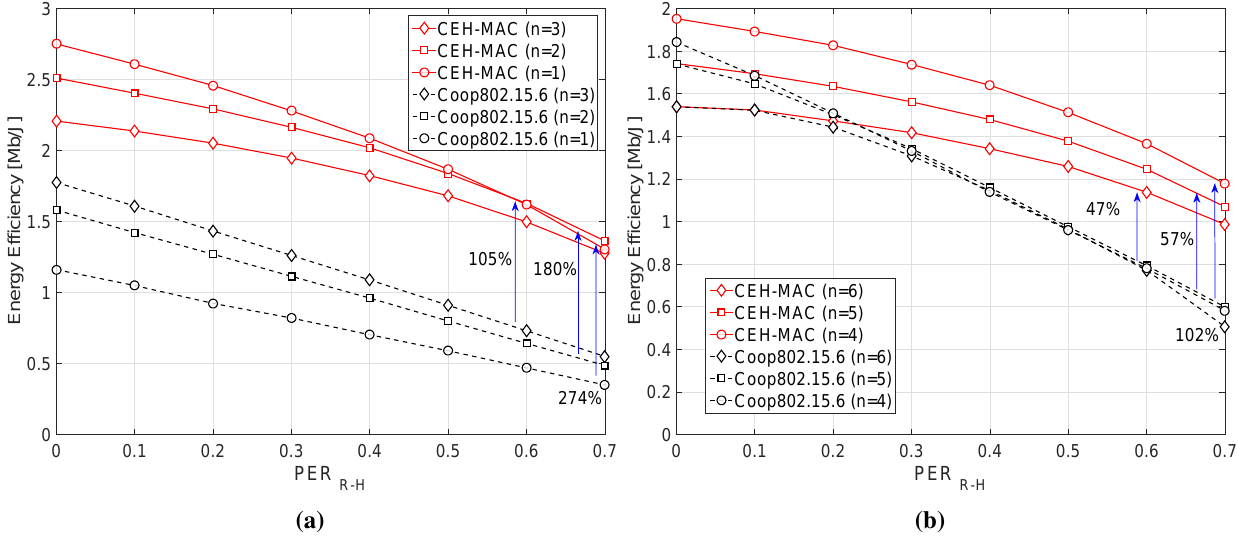
Figure 8. Energy efficiency performance. ( a ) n = 1 , 2 , 3 relays; ( b ) n = 4 , 5 , 6 relays. Table 2. Performance